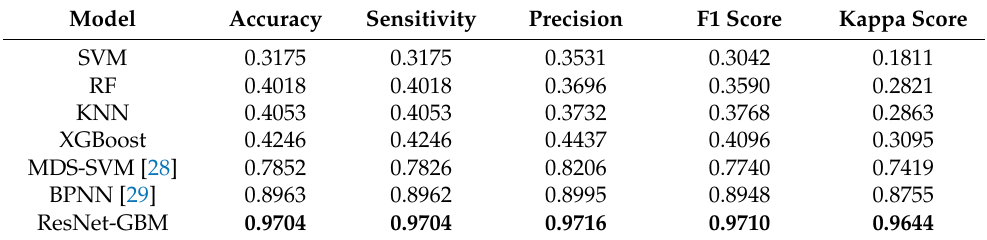
Table 6. Classification results of seven models in Experiment II.